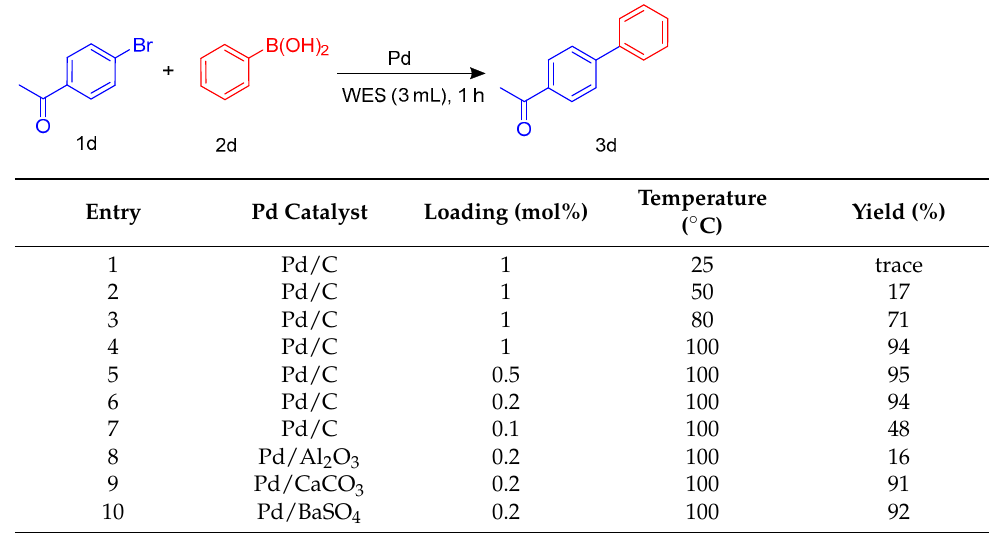
Table 1. Optimization of the Suzuki–Miyaura reaction conditions